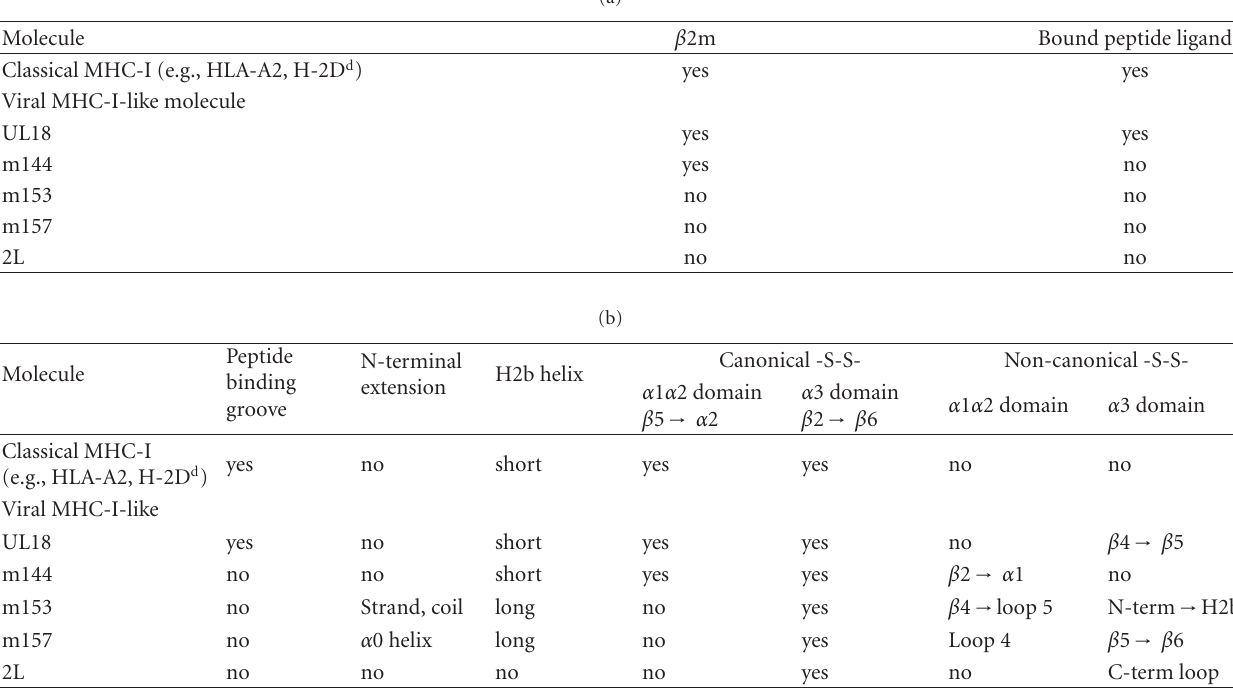
Table 1: (a) Subunit composition of MHC-I and MHC-I-like viral molecules. (b) Structural di ff erences among MHC-I and MHC-I-like viral